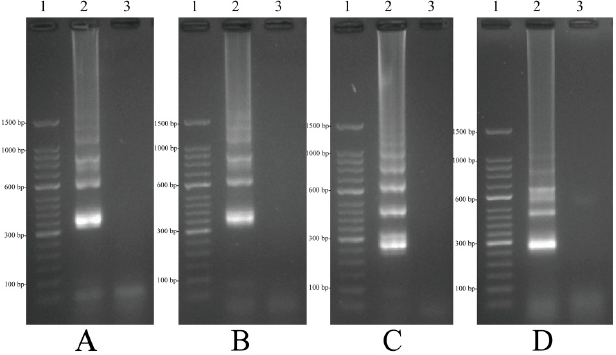
Figure 4. Agarose gel electrophoresis of 4 nLAMP products. ( A – D ): nLAMP assay using primers set G1, G2, G3 and G4, respectively. Lane 1, DL 50-bp DNA marker; lane 2, positive nLAMP products; lane 3 negative control.